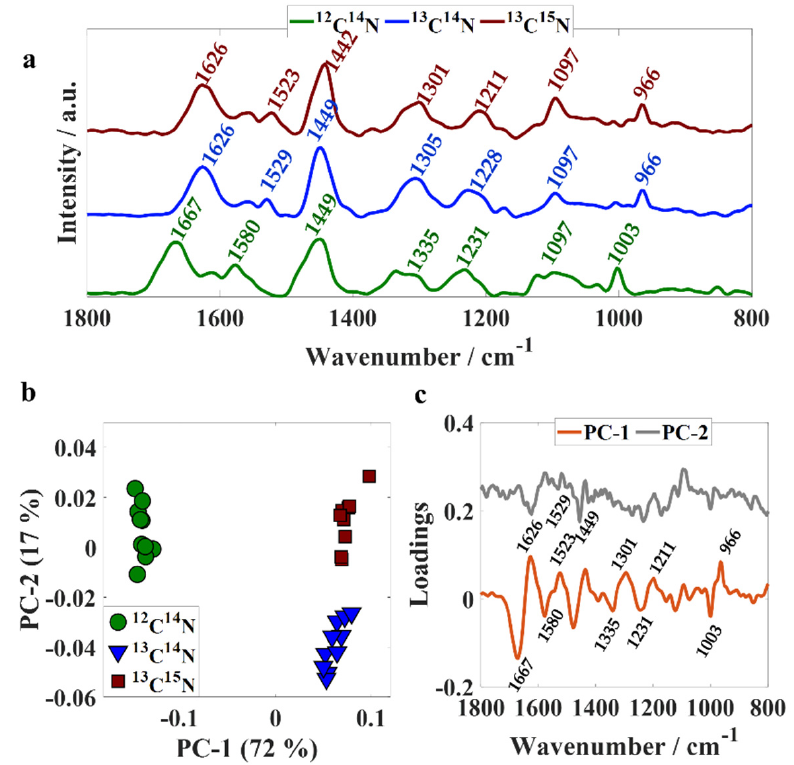
Figure 2. ( a ) Fingerprint region of averaged Raman spectra collected from E. coli bulk populations simultaneously with infrared data using O-PTIR system; 12 C 14 N (green line), 13 C 14 N (blue line), and 13 C 15 N (red line). Plots are offset for clarity. ( b ) PC scores plot; values in parentheses are the percentage total explained variance (TEV). ( c ) PC loading plot.